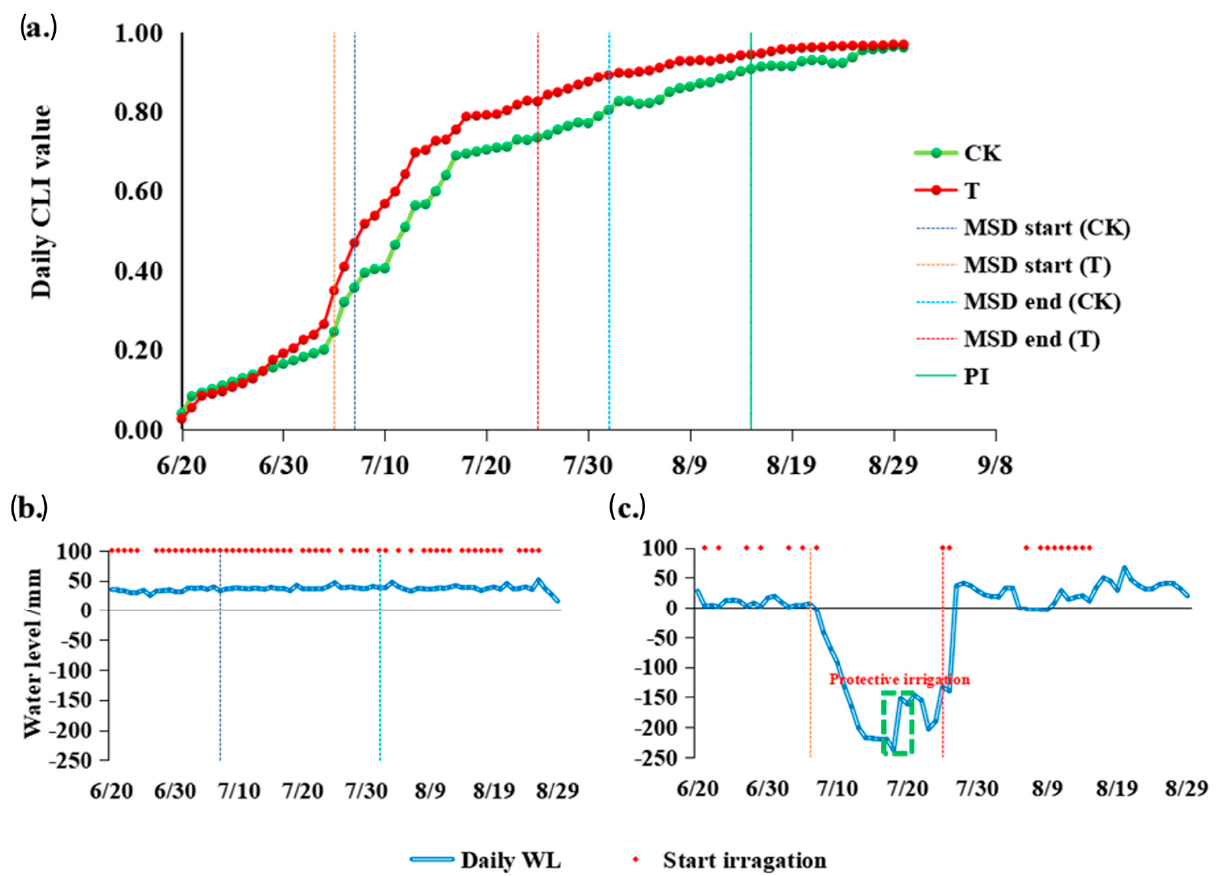
Figure 7. Daily CLI values ( a ) and soil water level in the CK ( b ) and T ( c ) treatments during the vegetative stage.